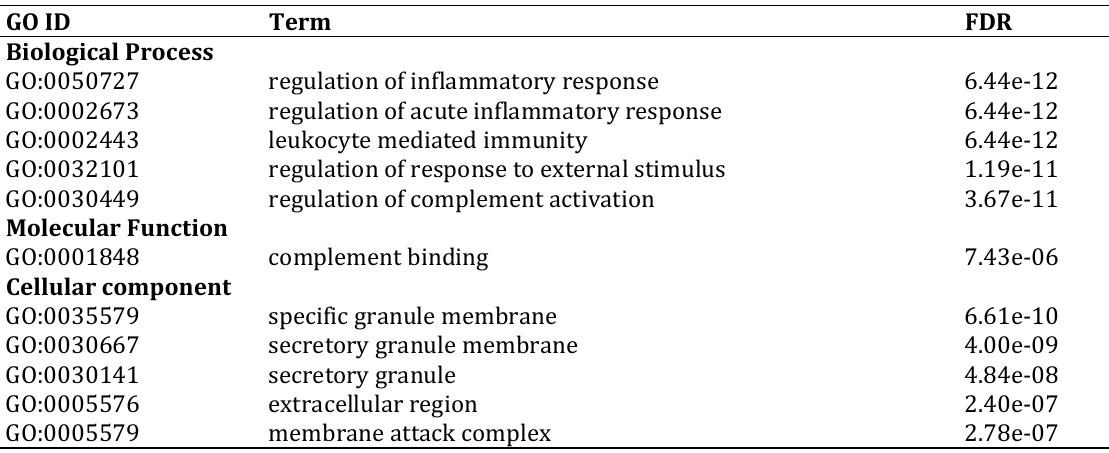
Table III. Top 5 results of GO enrichment analysis of the CD59 interaction network GO ID